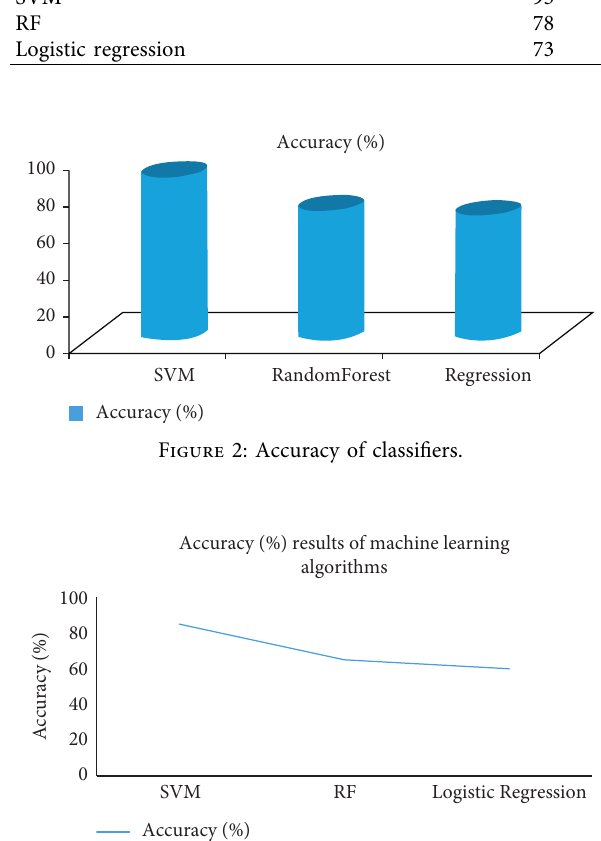
Figure 3: Graphical representation of accuracy results of machine learning